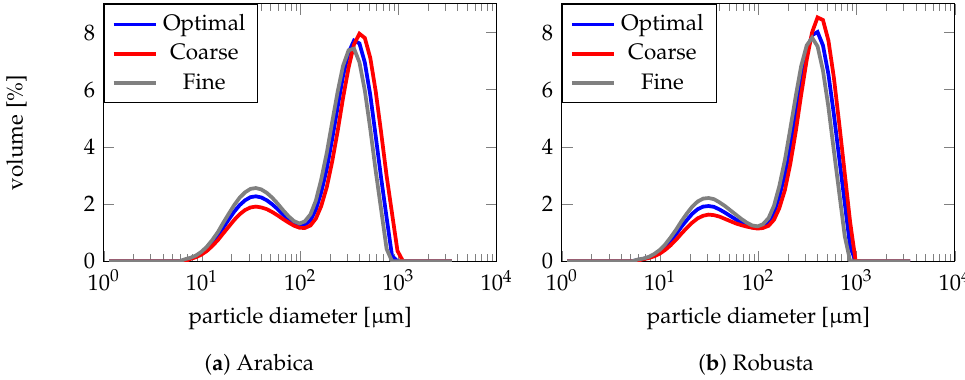
Figure 2. Particle size distributions of the ground coffee for Arabica variety ( a ) and Robusta variety ( b